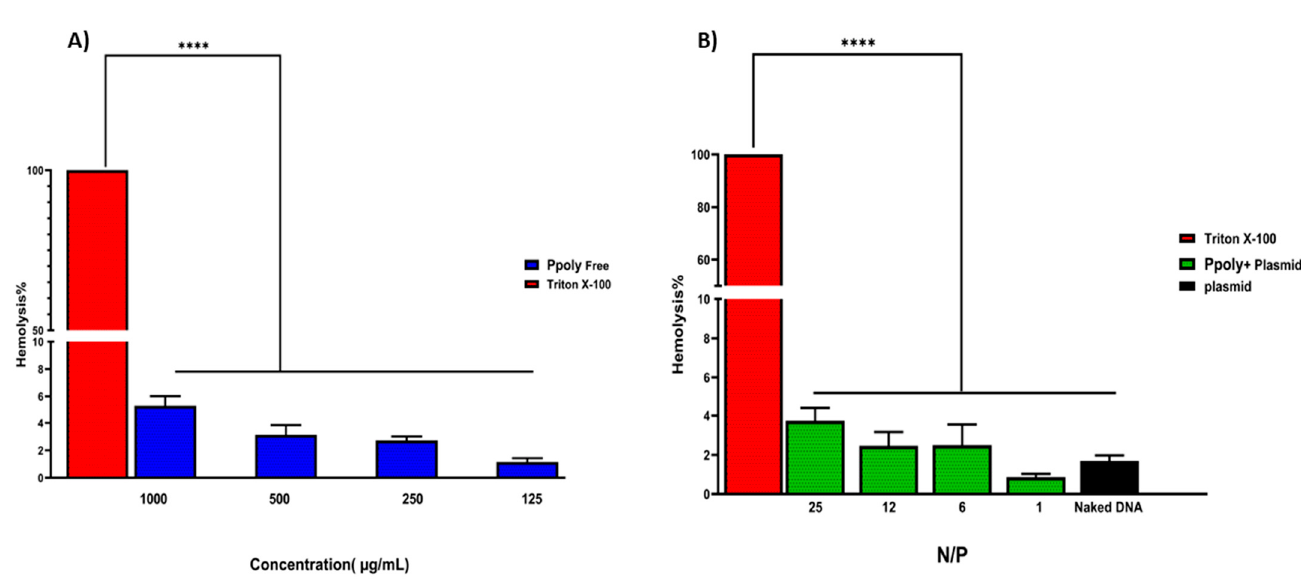
Figure 3. ( A ) Hemolysis percentages of RBCs at the concentration range of 125–1000 µg/mL of free PPoly. PBS and Triton X-100 were used as negative and positive control, respectively. ( B ) The He- molysis percentages of PPoly/pDNA with different N/P ratios (1, 6, 12, and 25) and free pDNA. The data is provided as mean ± S.D. (n = 3). **** p ˂ 0.0001 (n =